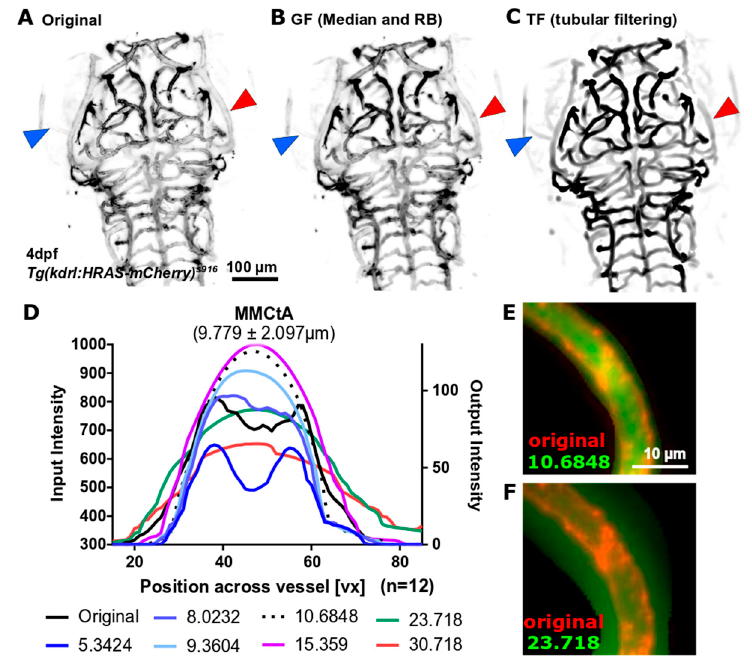
Figure 4. ( A ) Original data sometimes suffered from dimly visualized vessels (blue arrowhead) and had a double-peak cross-vessel intensity distribution (red arrowhead), which was particularly pronounced in bigger vessels. ( B ) Application of General Filtering (GF) failed to enhance dim vessels. ( C ) Application of Tubular Filtering (TF) successfully enhanced dim vessels and extracted vessels with double-peak intensity distributions as one segment (red arrowhead). ( D ) Assessment of the cross-vessel intensity distribution showed that the original double-peak distribution (black line; averages of n = 12 embryos) was successfully converted into a single-peak when scale reached vessel size (e.g., 9.3604 or 10.6848), while larger scales were found to reduce central intensity and blur vessel edges (e.g., 15.359 and above). This was further validated by visual investigation ( E , F ) where the TF response is shown in green overlaid onto the original image in red.